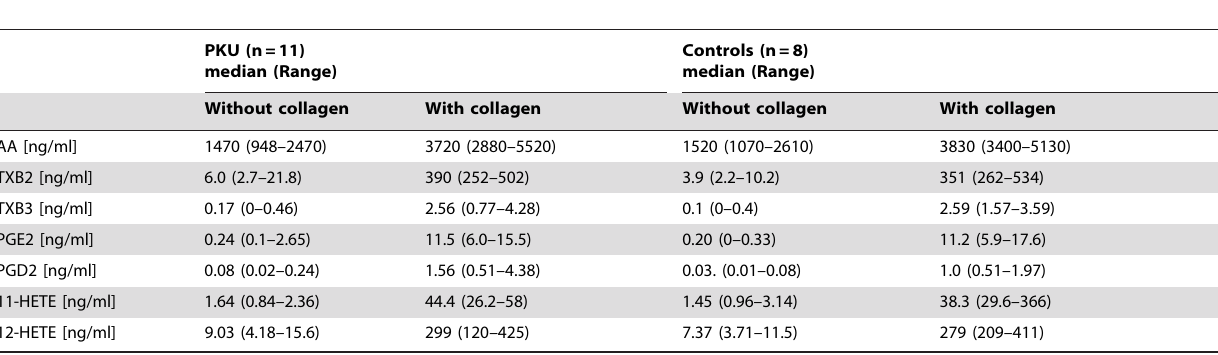
Table 2. Eicosanoid concentrations in supernatants after 10 minutes of activation of platelet rich plasma (225 m l; 150 6 15 Gpt/l) with/without collagen in patients with phenylketonuria (PKU) and healty controls.